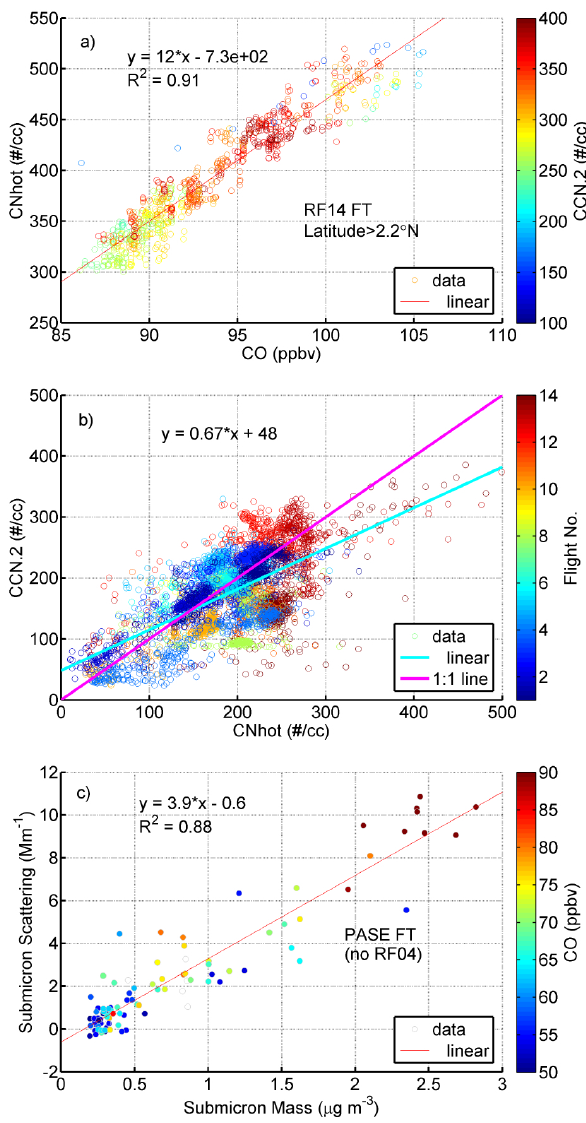
Fig. 7. (a) An example of typical correlation between CNhot and CO in an elevated CO FT layer colored with CCN.2; (b) the relation between CNhot and CCN.2 for all PASE flights colored with flight number; and (c) submicrometer light scattering vs. submicrometer mass from the OPC above TWI colored with